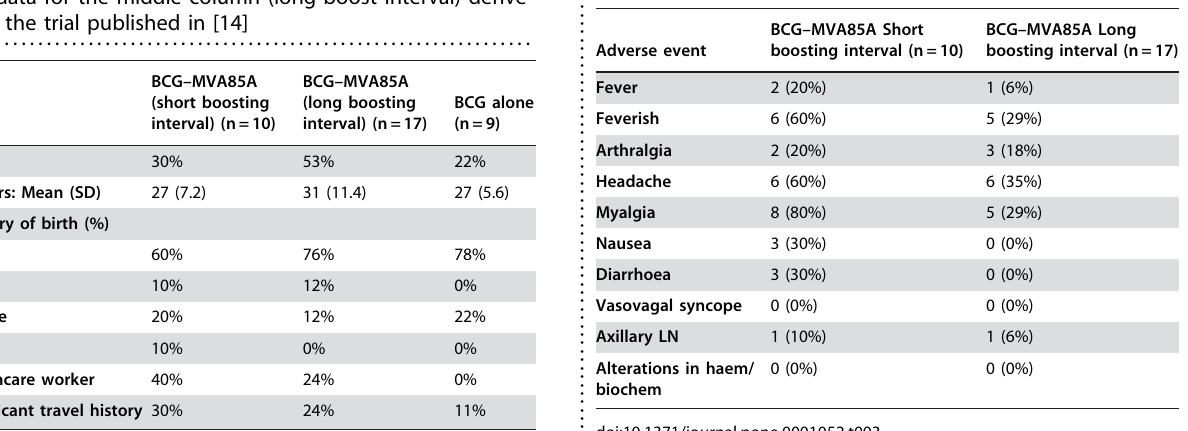
Table 3. Systemic adverse events after MVA85A vaccination ... ... ... .... ... ... .... ... ... .... ... ... .... ... ... .... ... ... .... ... ...